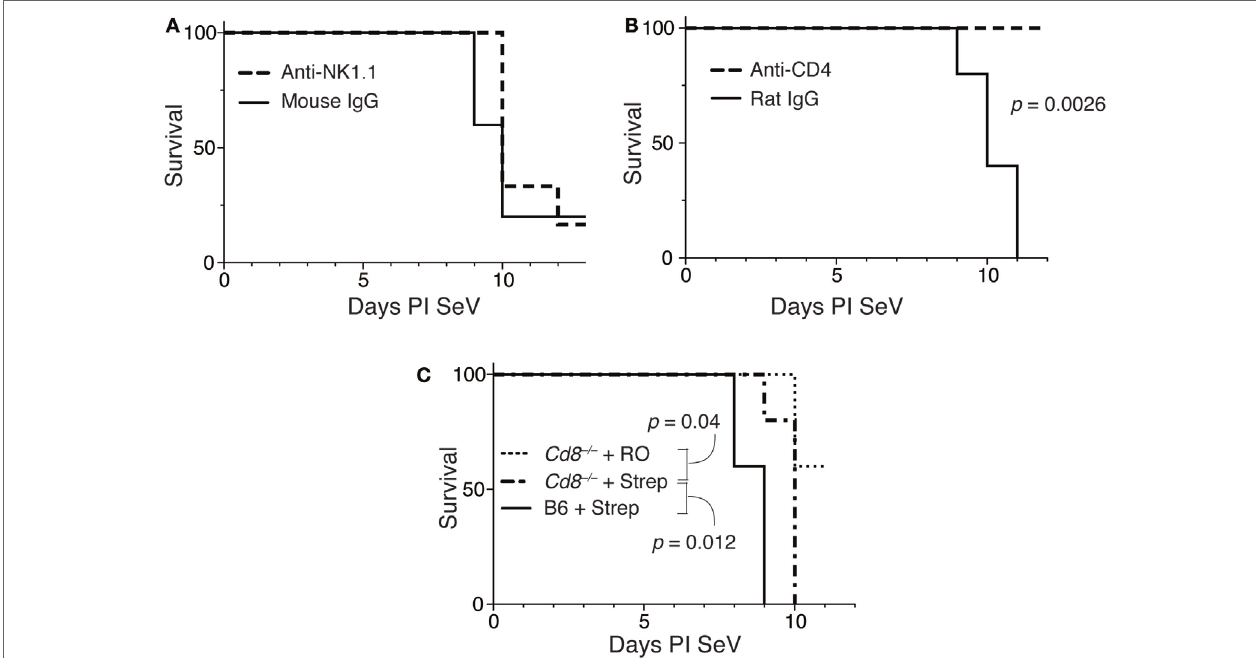
FigUre 6 | Increased mortality in streptomycin-treated mice requires CD4 + cells, but not IFN γ -producing CD4 T cells. (a) Mice were treated as in Figure 4 , and at day 5 and 9 PI Sendai virus (SeV), 100 µg of anti-NK1.1 or control mouse IgG monoclonal antibody was administered SQ. Mortality was then measured. (B) Mice were treated as in panel (a) using anti-CD4 or control rat IgG monoclonal antibodies, and mortality was measured. (c) Wild-type (C57BL/6) or CD8-deficient ( Cd8 − / − ) mice were treated as in panel (a) , and mortality measured. For all of these experiments n =